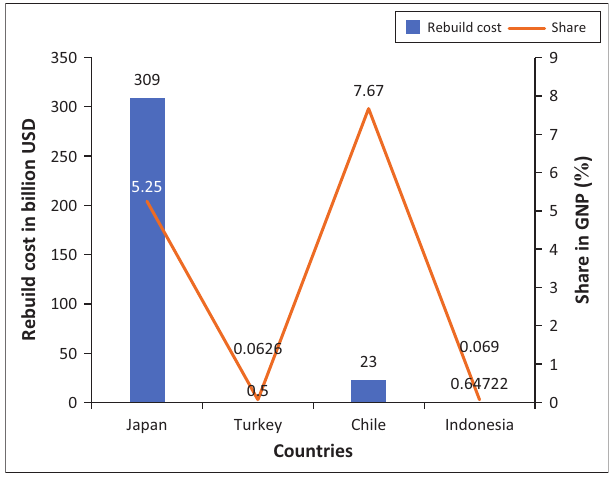
FIGURE 8: The comparison of rebuild cost and share in gross national product ( % ) from different countries.